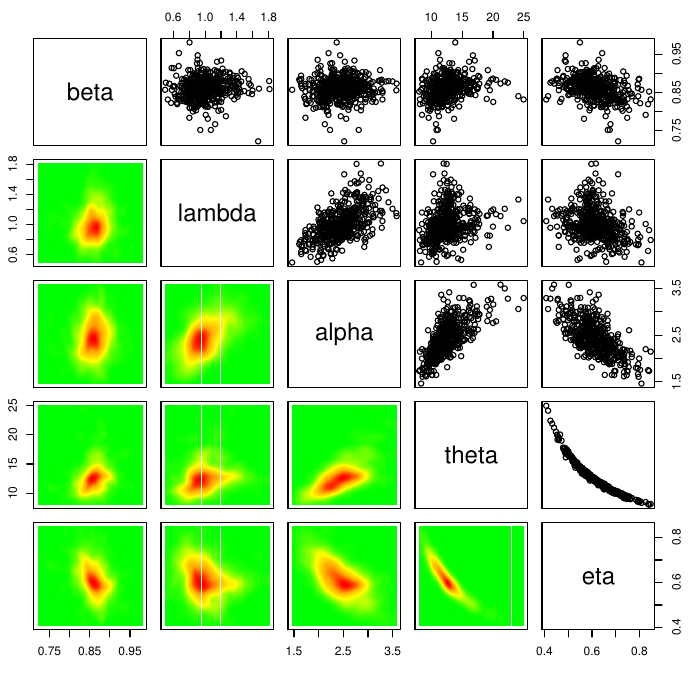
Figure 5 – Parametric bootstrapped values of parameters of GOTTS-E distribution for the first data